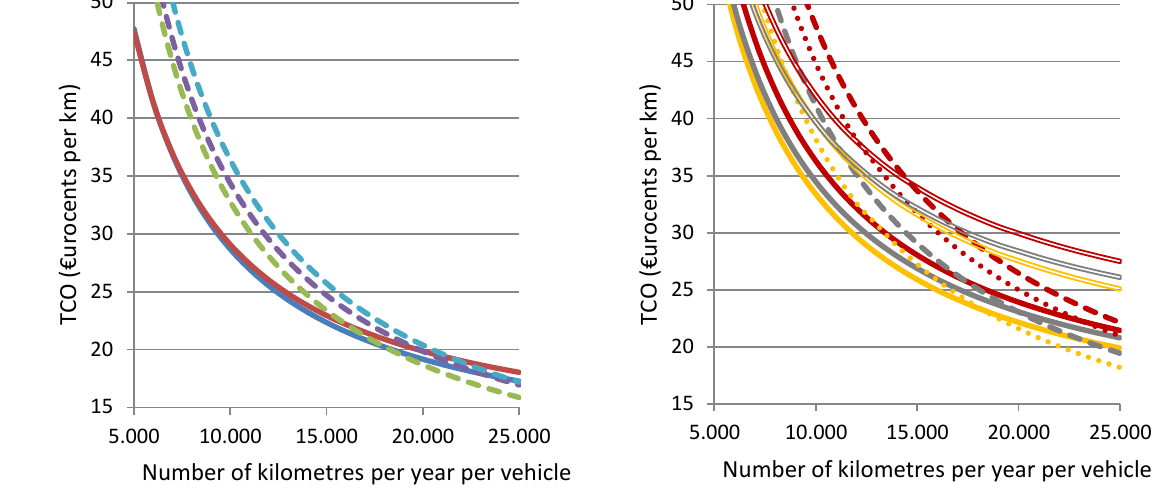
Figure 3. TCO sensitivity on the kilometres driven per year by the quadricycles